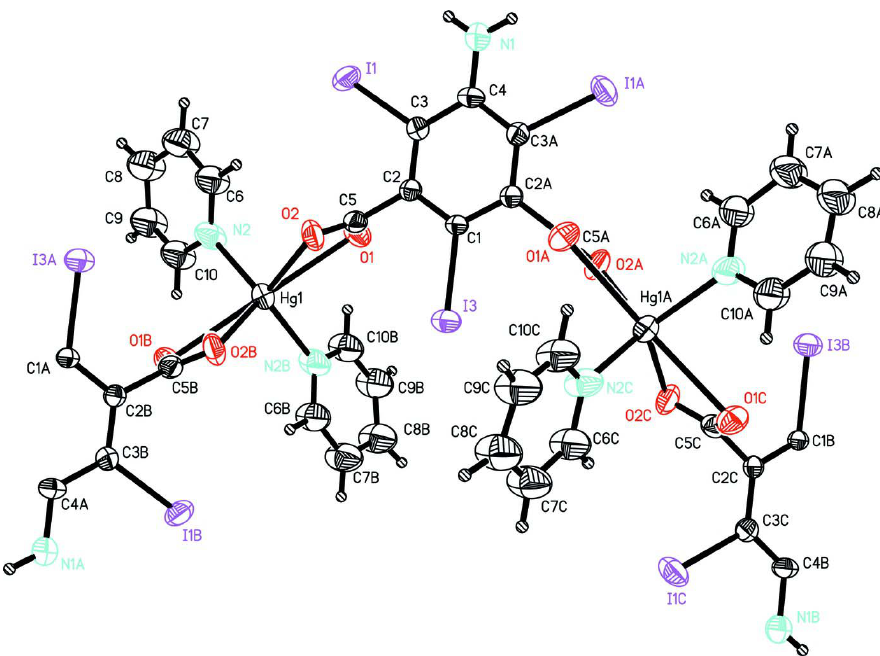
The molecular structure of title compound, with atom labels and 30% probability displacement ellipsoids. All H atoms have been